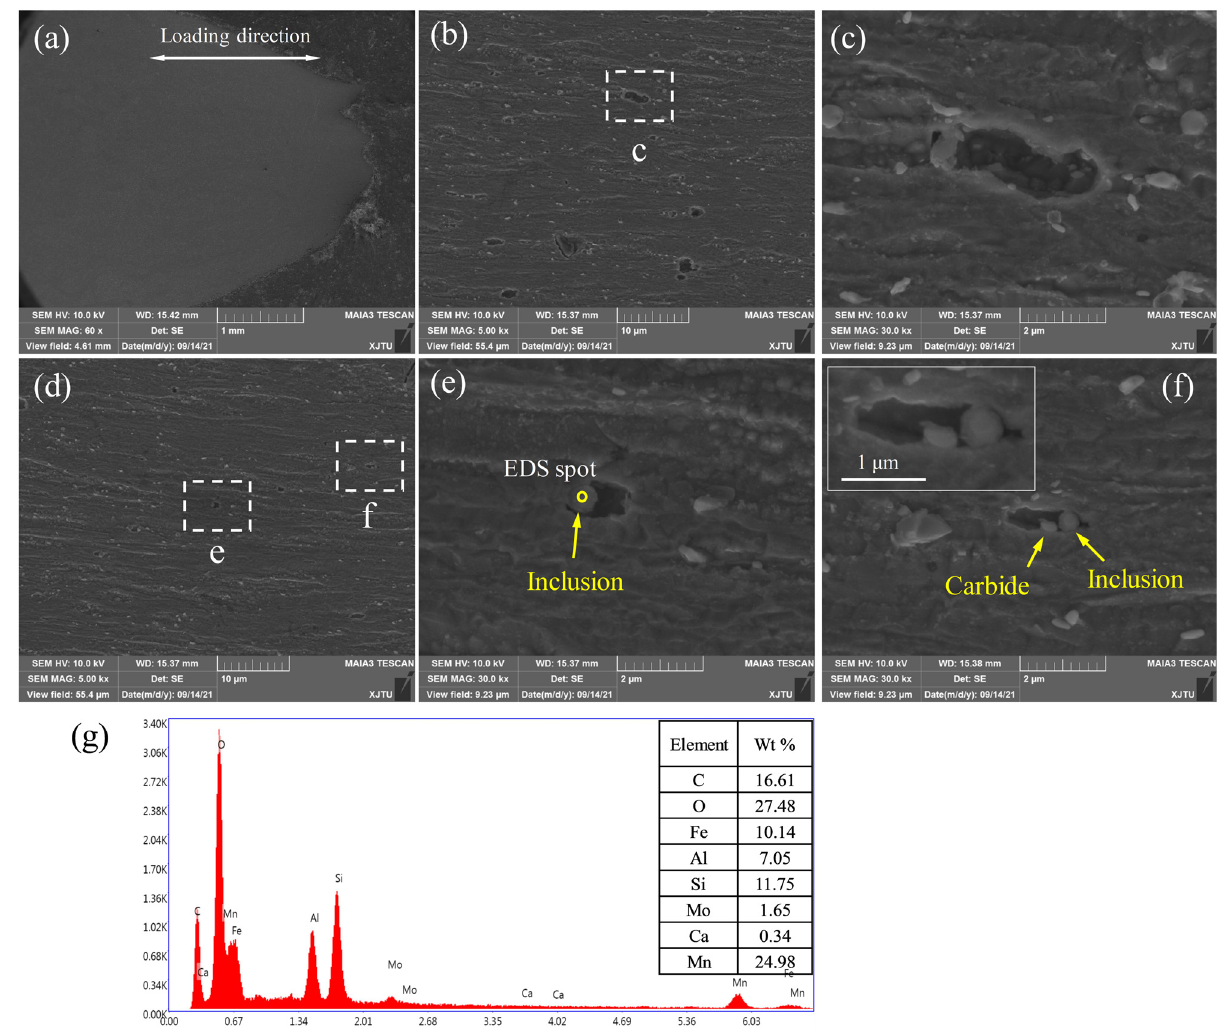
Figure 15: SEM images showing the damage zones of the creep ruptured WM specimen under the stress of 275 MPa. ( a ) The entire image of longitudinal cross - section; ( b ) and ( d ) are the distribution of creep cavities in WM; ( c ) – ( f ) are the morphologies of creep cavities in ( b ) and ( d ) ; and ( g ) is the point scanning by EDS for the inclusion in the creep cavity in the